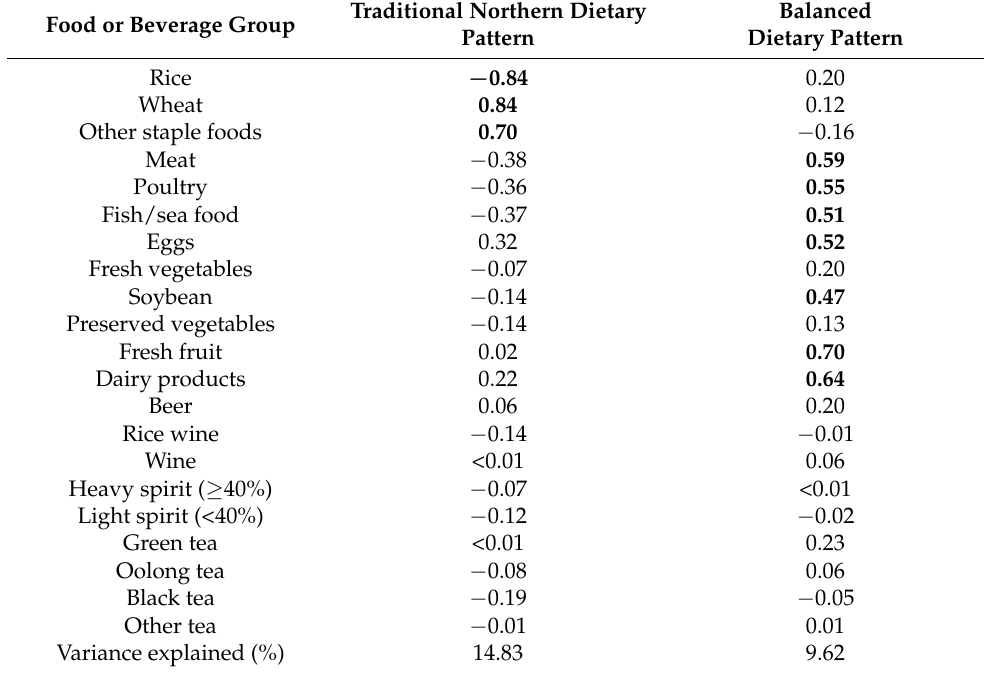
Table 1. Factor loading matrix of major dietary patterns by principal component analysis with varimax rotation (n =